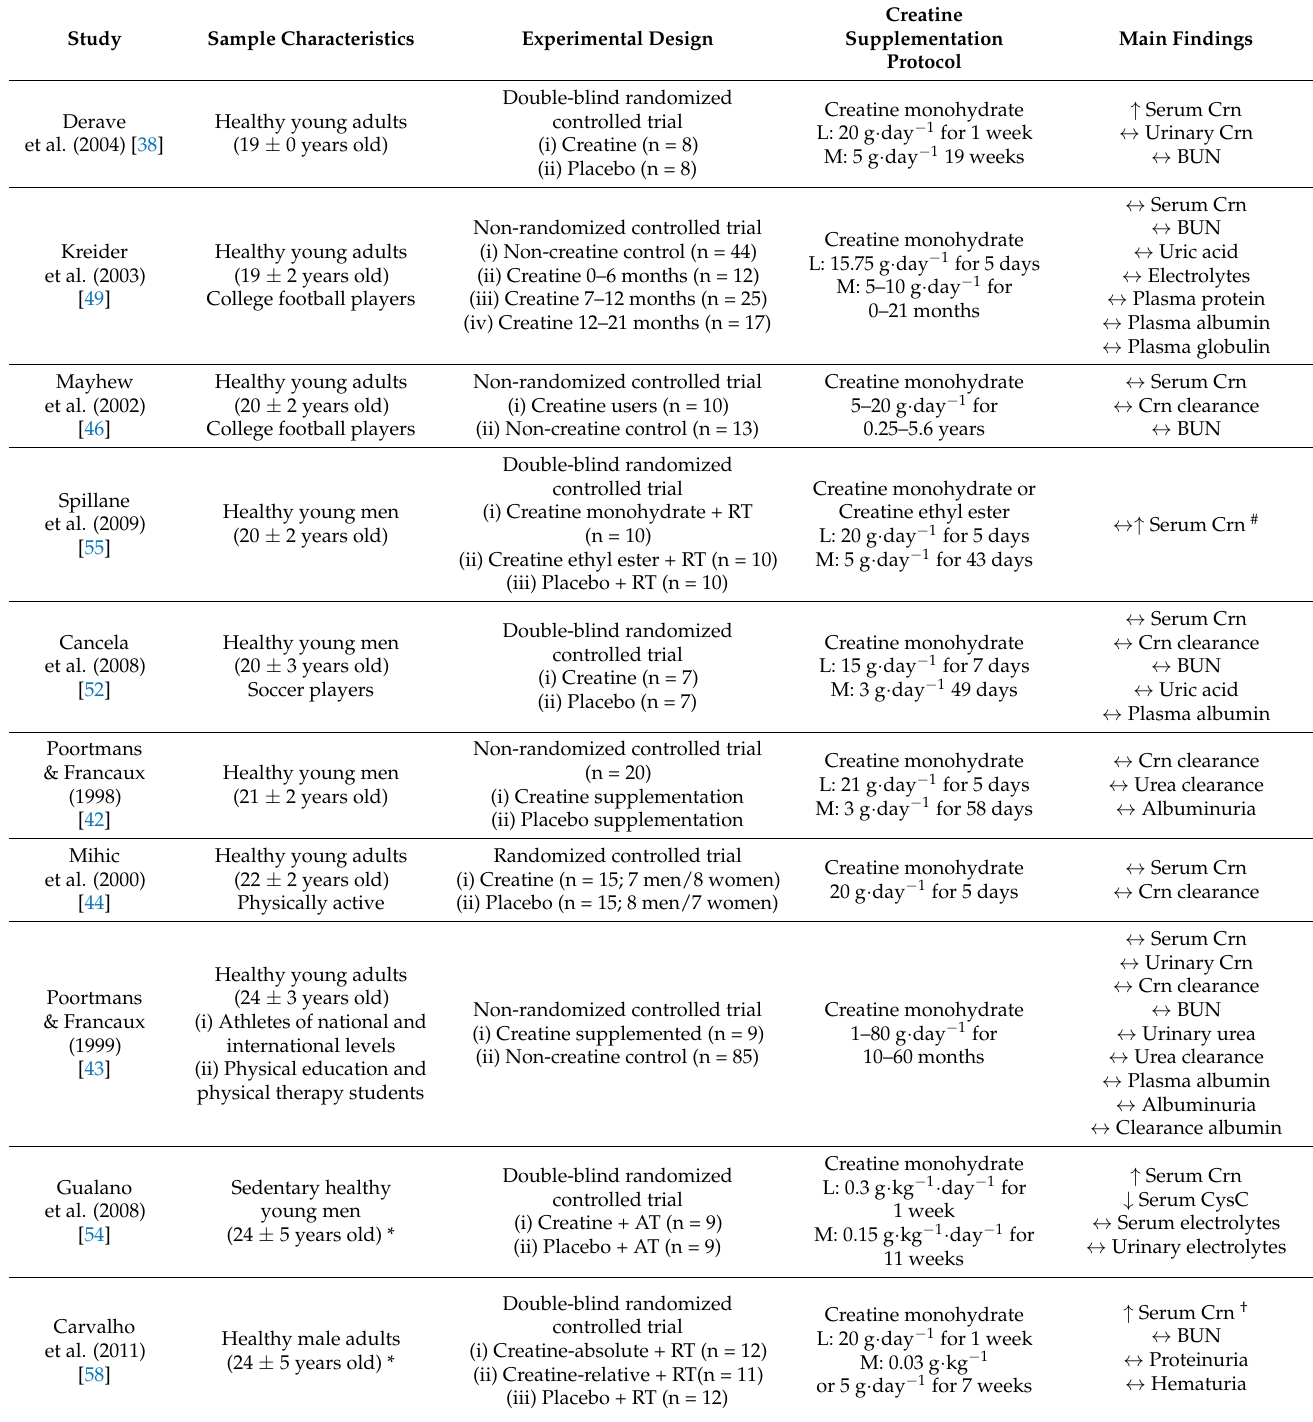
Table 3. Experimental studies investigating the effects of creatine supplementation on kidney function in healthy